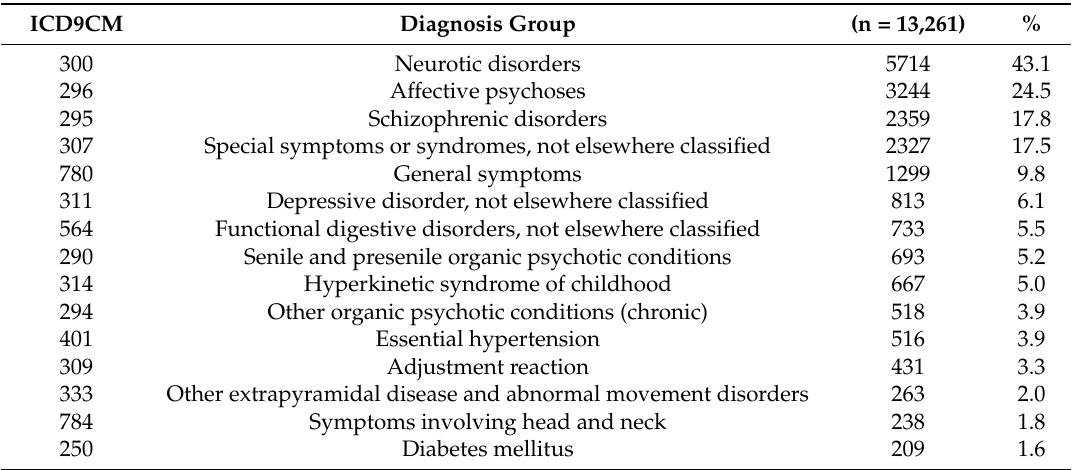
Table 1. The distribution of diagnoses among psychiatric outpatients with all diagnoses at each claim were taken into